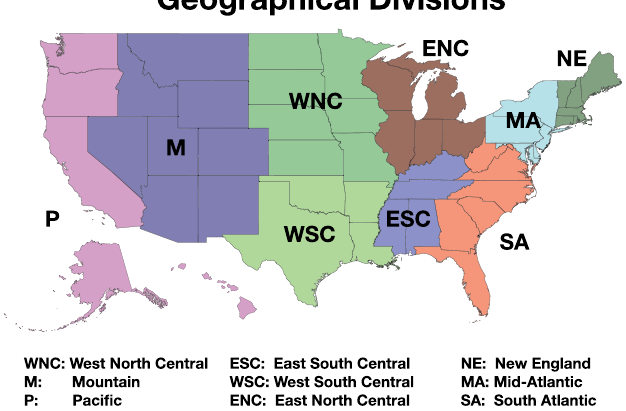
Figure 1. Illustration of the geographical divisions of the US used in this study.